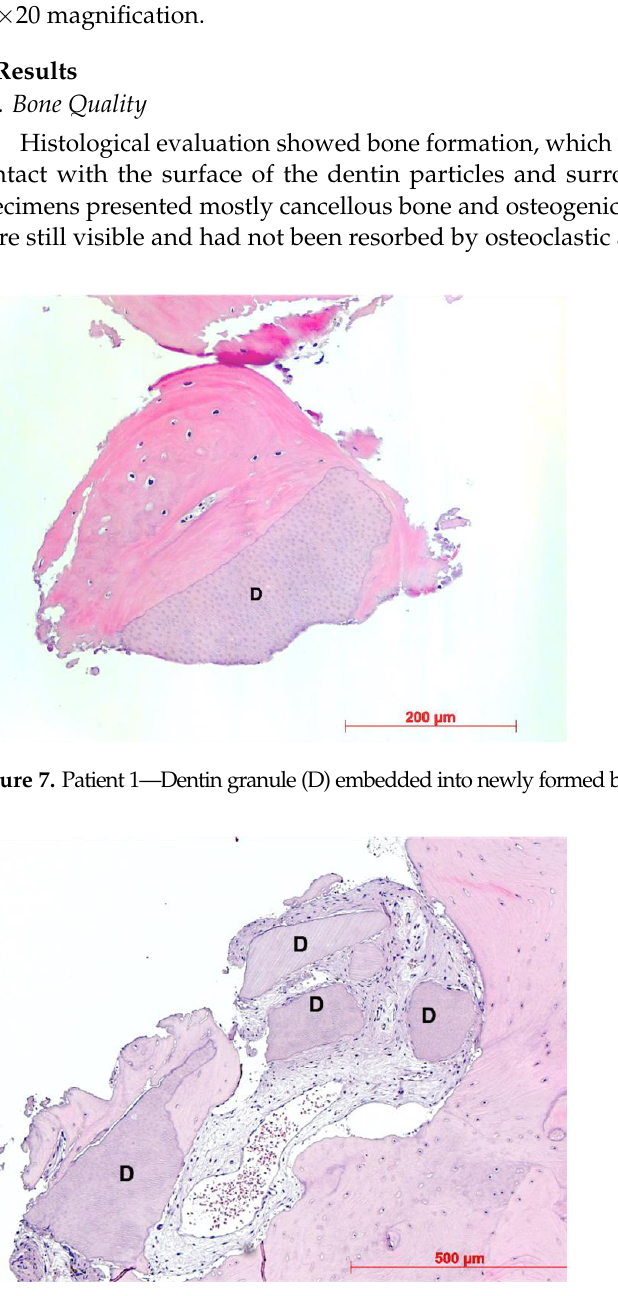
Figure 8. Patient 2 — Newly formed bone, dentin granules (D) with and without osteogenesis, HE, original magnification ×20.